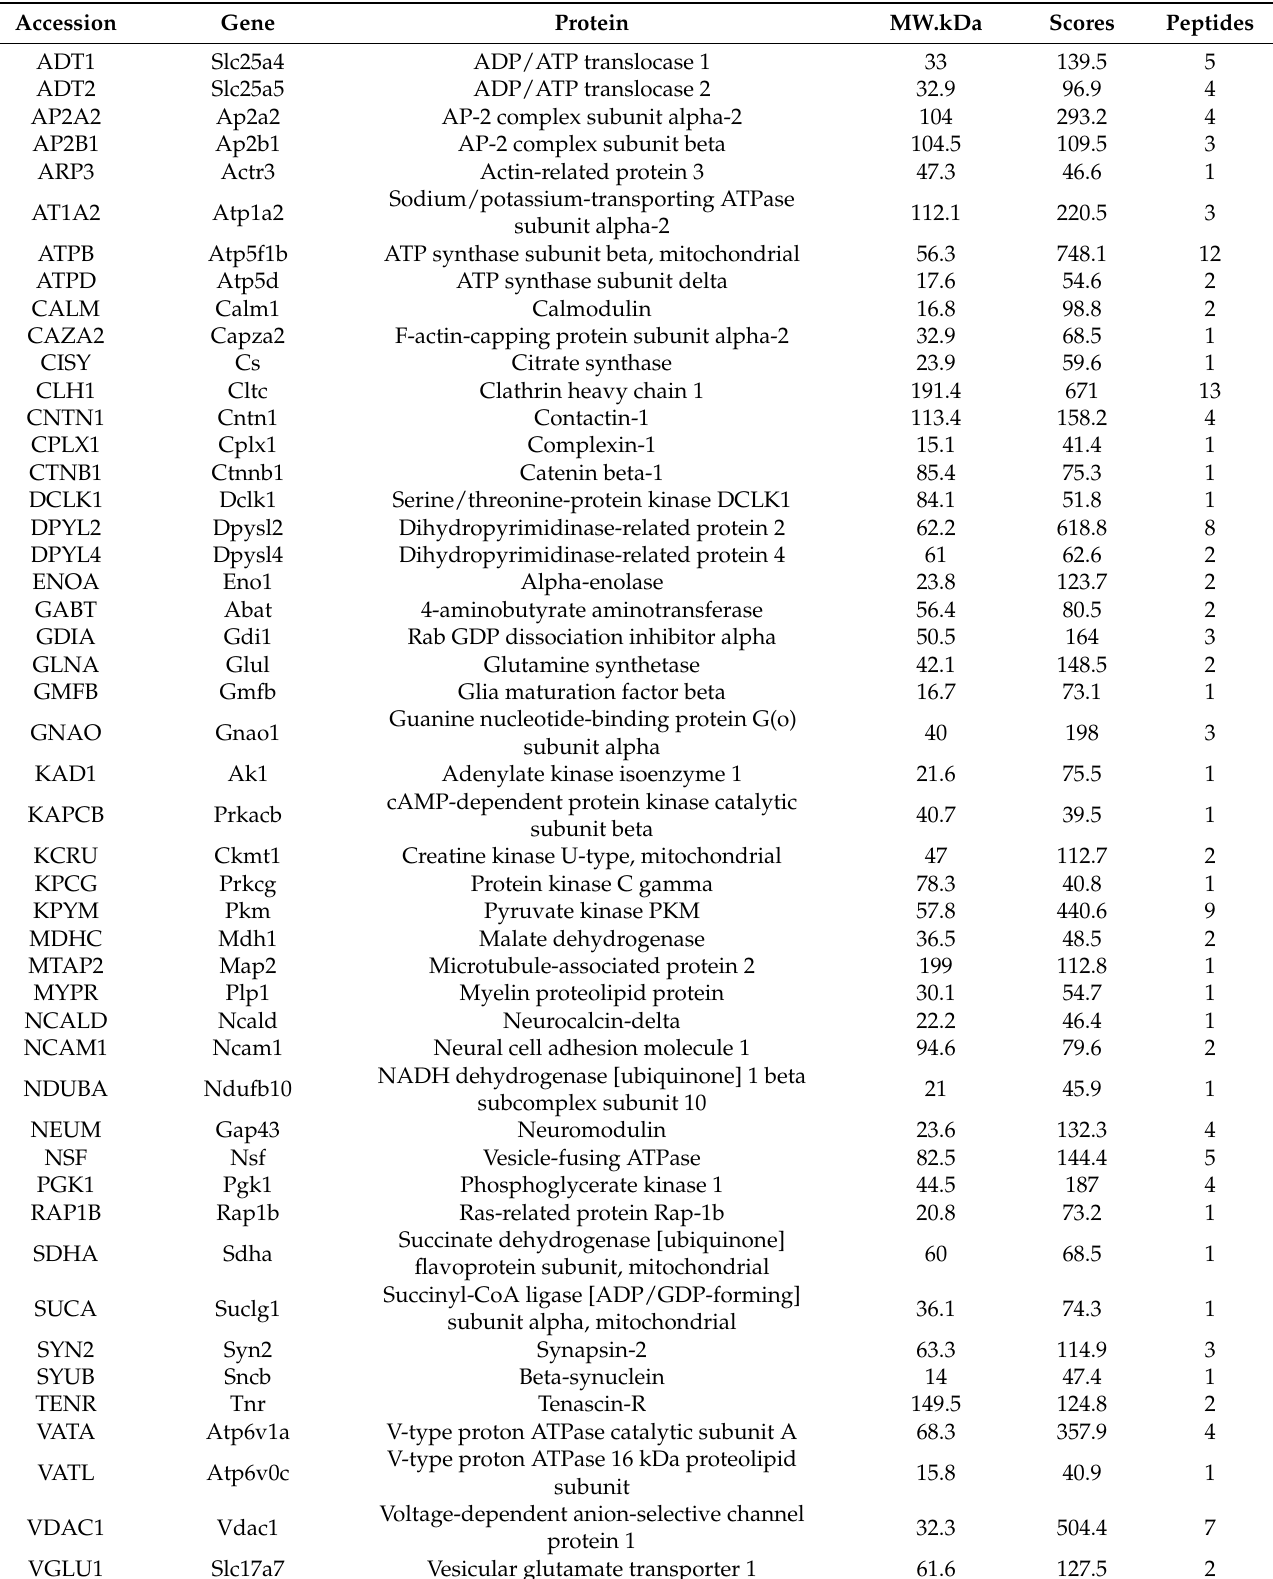
Table 1. The list of 48 proteins identified in the adult medial prefrontal cortex of the male rats in the proteomic analysis. For each protein match, Mascot calculates an overall Protein Score. This number reflects the combined scores of all observed mass spectra that can be matched to amino acid sequences within that protein. A higher score indicates a more confident